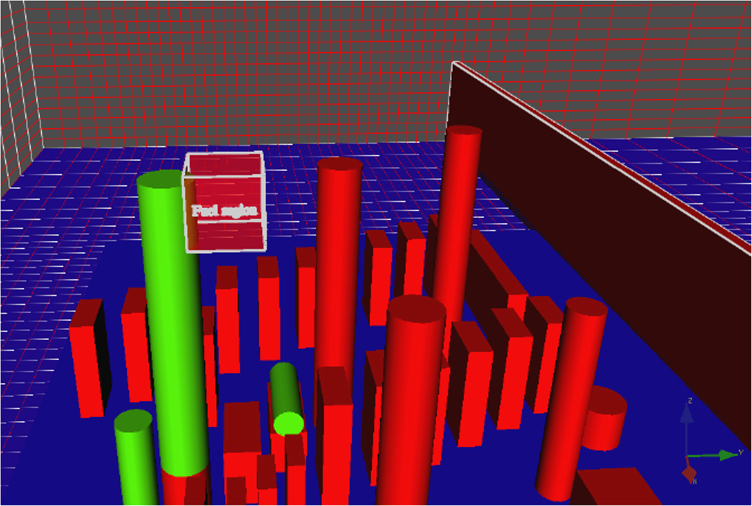
Explosion geometry.